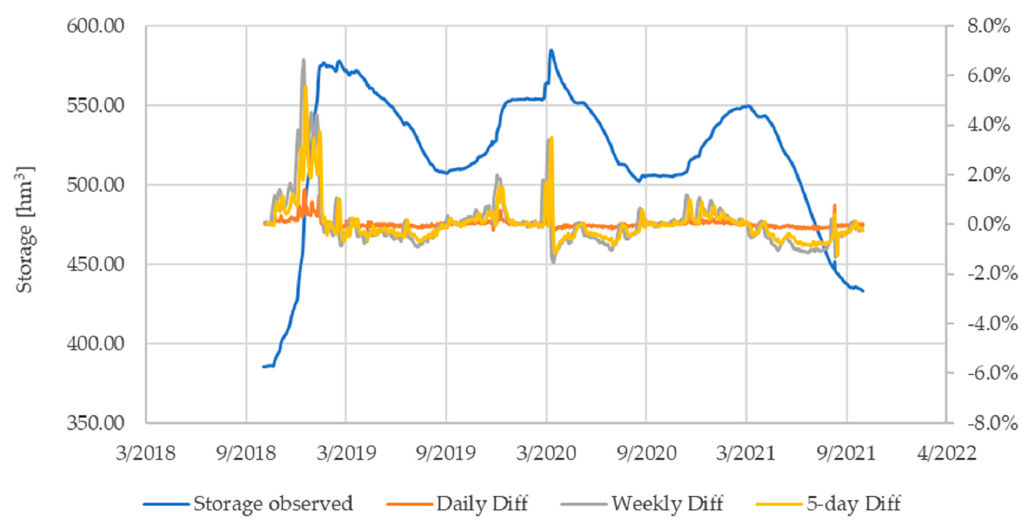
Figure 10. Yliki reservoir water storage variation and percentage of reservoir’s maximum storage for daily, weekly, and 5-day time lags between Sentinel-2 and Sentinel-3 paired measurements. The number of quasi-synchronous water level and area pairs, derived from each time lag option, are compared. The number of pairs from the 7-day time lag is significantly greater than the daily and 5-day time lag. More explicitly, if a 7-day time lag is chosen, 28 pairs of water level and area are derived. On the contrary, the 5-day and the daily time lag produce 20 and 2 pairs, respectively. Thus, the choice of a 7-day time lag and the con- sequent acceptance of about 1% higher variation of storage provides 40% more measure- ments than the 5-day time lag, in order to validate the most suitable storage variation estimator (see Section 3.4). As also discussed in Sections 3.1 and 3.2, both the normalized water area and level time series are found to closely follow the normalized storage observations. The 28 paired water level and area pairs present correlation of 97.95%. Each of the two time series pre- sent correlations with the storage observations of 99.04% and 98.73%. Regarding each pair’s storage variation between the water level and area measurements dates, this stands for 0.29%. Figure 11 presents the abovementioned 28 double pairs of water level–water area and water level–water storage. The derived empirical relationships show a strong linear be- havior. It is observed that the coefficient of determination, R 2 , of the empirical relationship between the level estimated and the observed storage is higher than the R 2 between the estimated water level and the estimated area. The above is considered reasonable; hence the latter relationship inherits the uncertainties of both Sentinel-2 and Sentinel-3 missions and the proposed methodology.